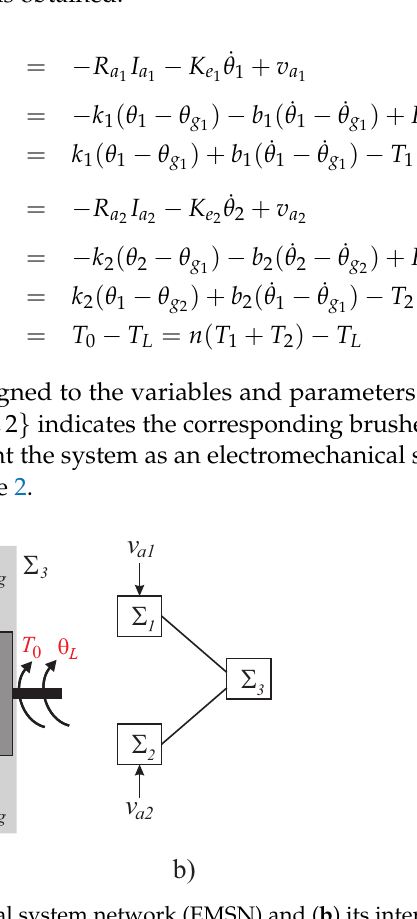
Figure 2. ( a ) Electromechanical system network (EMSN) and ( b ) its interconnection